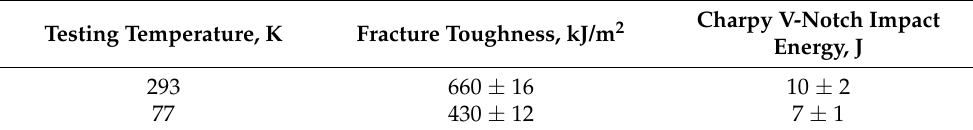
Table 4. Charpy V-notch impact energy and fracture toughness of the as-printed